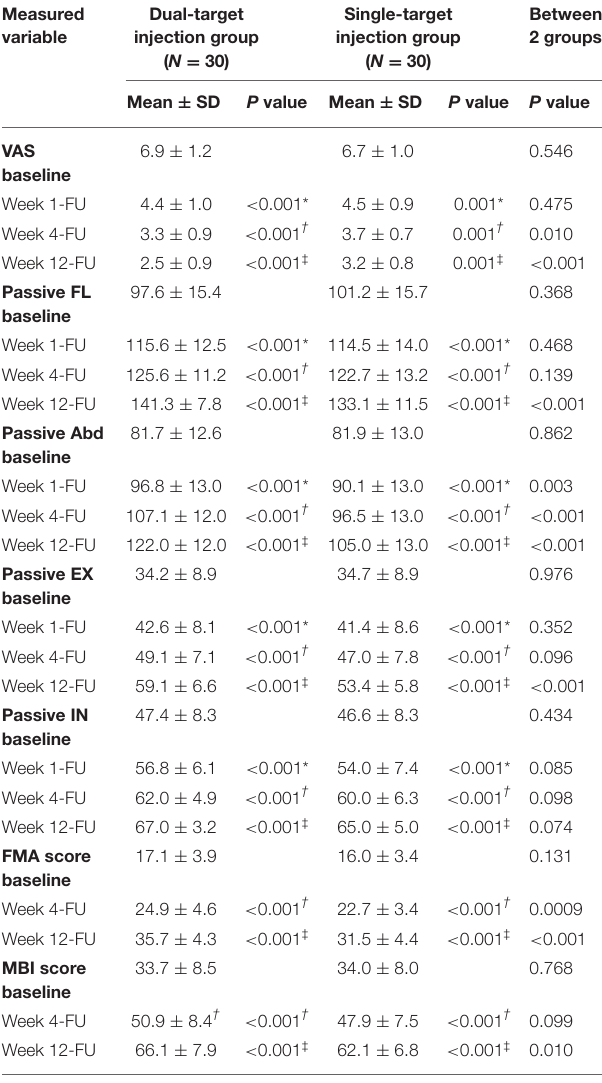
Values represent the mean ± standard deviation. VAS, visual analog scale; FU, follow up; FL, flexion; Abd, abduction; EX, extension; IN, internal rotation; UEFMA, Upper Extremity Fugl-Meyer Assessment; MBI, Modified Barthel. P values pertain to between- group comparison for difference from baseline. * Significant difference between baseline andoneweekposttreatmentinthesamegroup(p < 0.05). † Significantdifferencebetween baseline and weeks 4 posttreatment in the same group (p < 0.05). ‡ Significant difference between baseline and weeks 12 posttreatment in the same group (p <